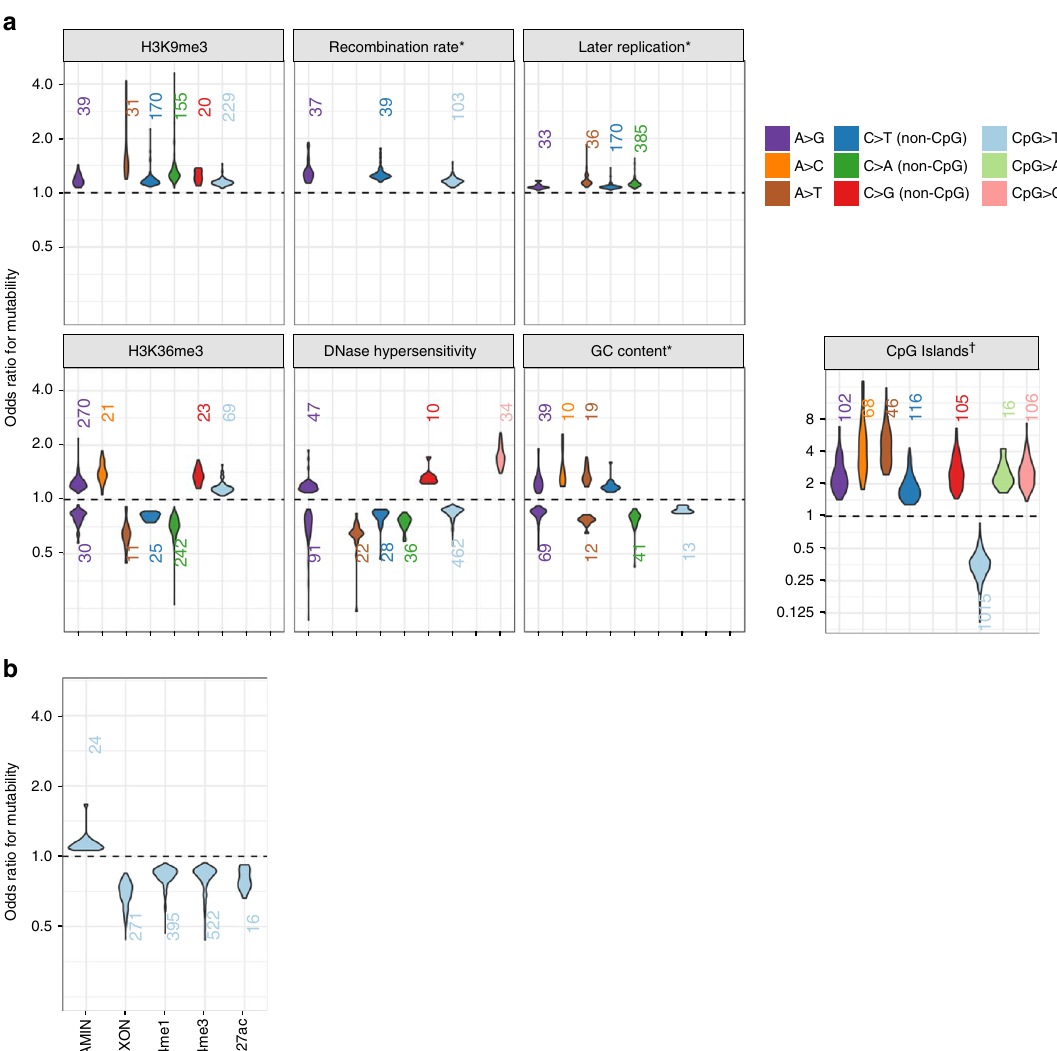
Fig. 3 Distributions of statistically signi fi cant mutagenic effects of genomic features. a Effects of seven genomic features where associations with multiple mutation types were detected. For features with bidirectional effects, we separately plotted distributions of positive associations (OR > 1; above dashed line) and negative associations (OR < 1; below dashed line). The number of 7-mer subtypes within each type for which that feature is statistically signi fi cant in a positive or negative direction is shown above or below each distribution. Distributions are only shown for types with 10 or more 7-mer subtypes associated in the same direction. *Odds ratios for the three continuously valued features (recombination rate, replication timing, and GC content) indicate the change in odds of mutability per 10% increase in the value of that feature. † Effects in CpG islands tend to be stronger than other features, so are shown on a wider scale. b Distributions of signi fi cant mutagenic effects for the 5 features only associated with CpG > TpG